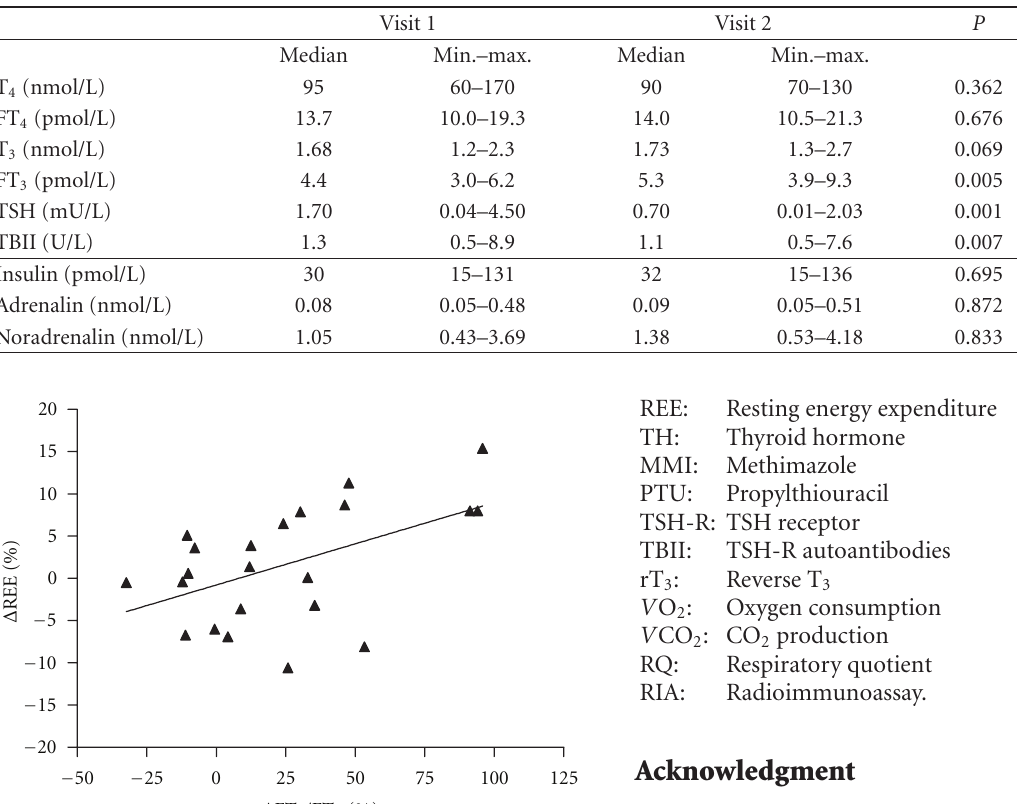
Table 4: Plasma hormone concentrations at visit 1 and visit 2.